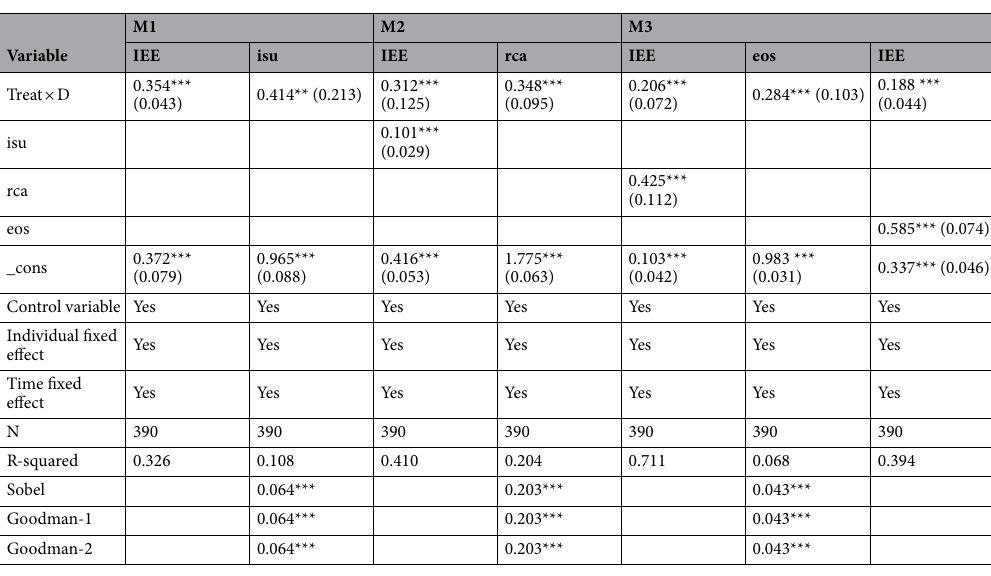
Table 8. Mediating effect test results. ***, ** and * represent significance levels of 1%, 5% and 10% respectively, standard error is in